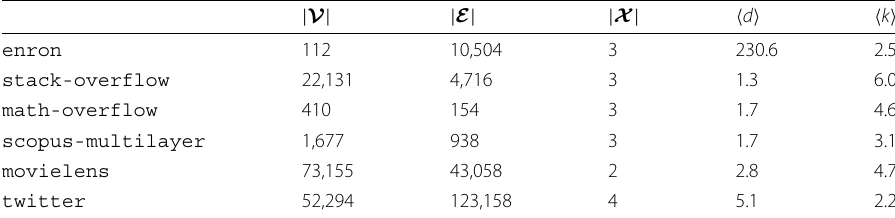
Table 1 Descriptive statistics for each data set